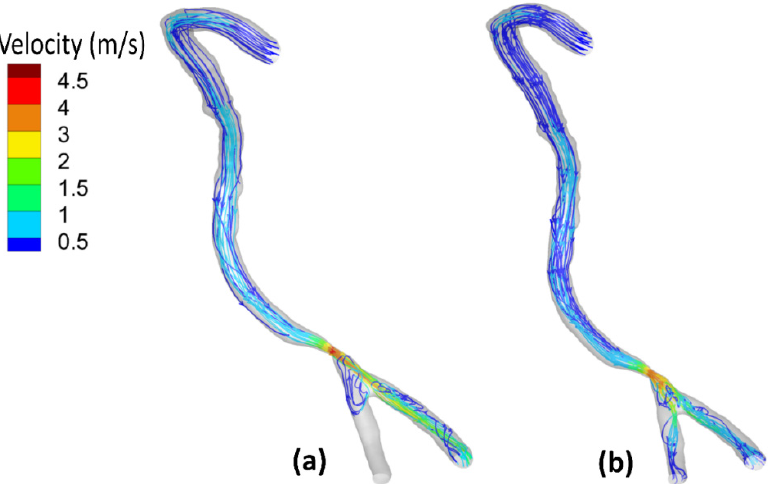
Figure 7. Streamlines at the peak systole for stenotic RCA (model A): ( a ) elastic wall, ( b ) rigid wall.